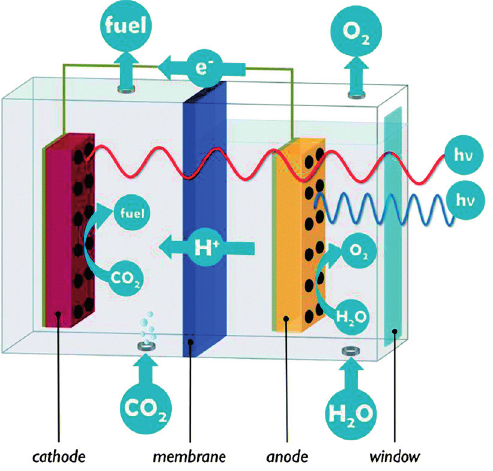
Figure 28. Liquid-phase 2-compartment PEC cell for CO 2 photo-reduction. (reproduced from [79] with permission of the Royal Society of Chemistry).